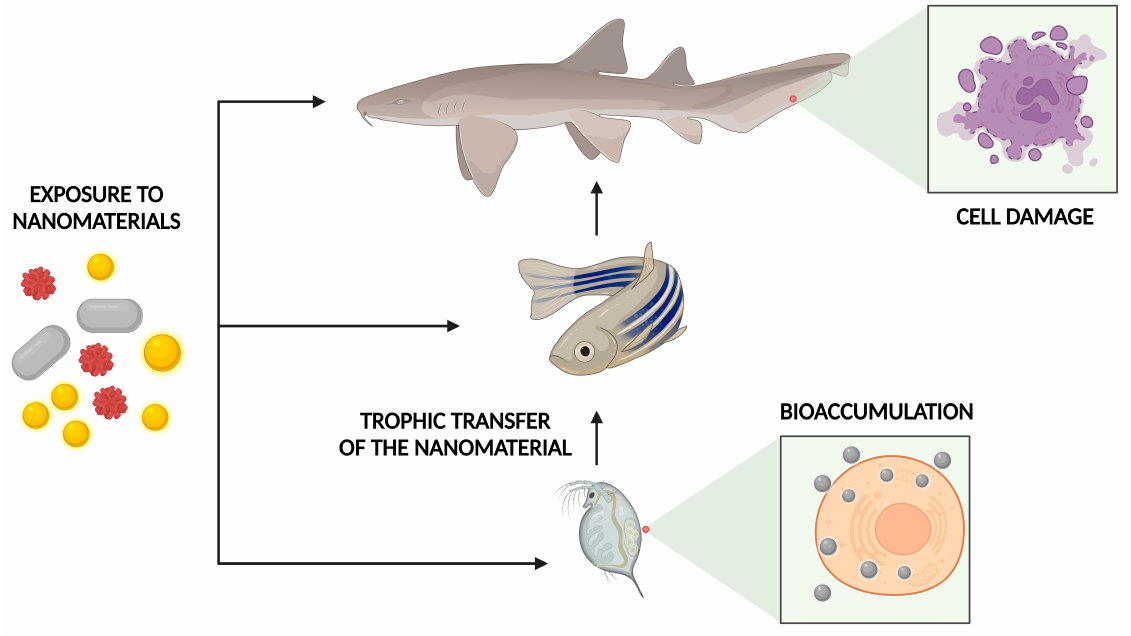
Figure 6. NMs can cause harm associated with acute and chronic exposure that can affect the entire food chain. NMs can directly affect each member of a food chain and accumulate in their tissues. Furthermore, this accumulation can be transferred through the trophic levels, causing even greater damage, mainly to the top predator of the chain.